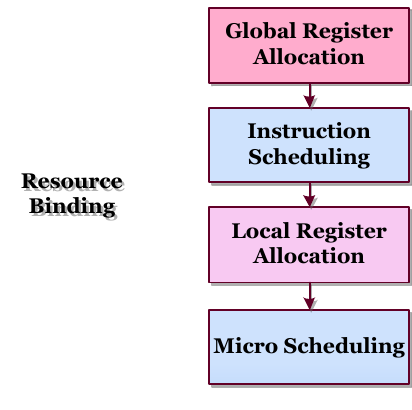
Figure 3. Illustration of the Resource Binding